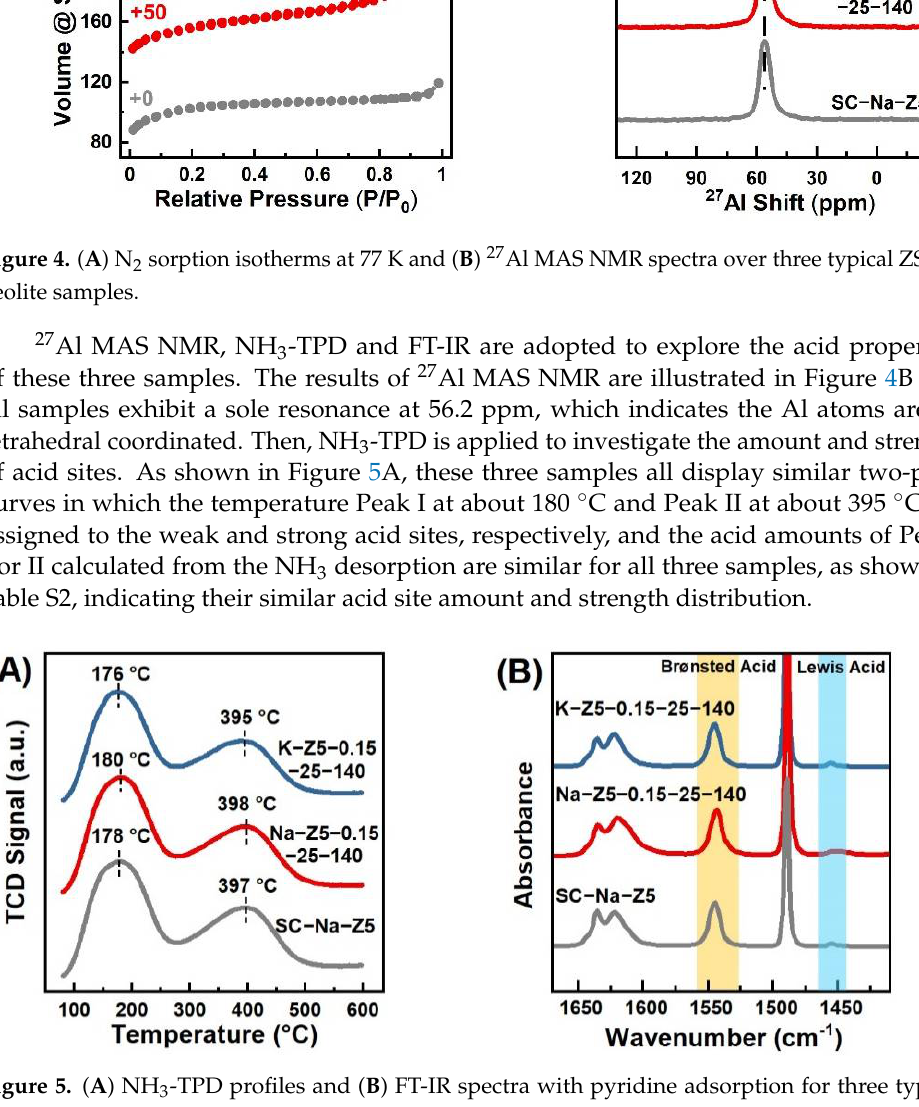
Figure 5. ( A ) NH 3 -TPD profiles and ( B ) FT-IR spectra with pyridine adsorption for three typical ZSM-5 zeolite samples.